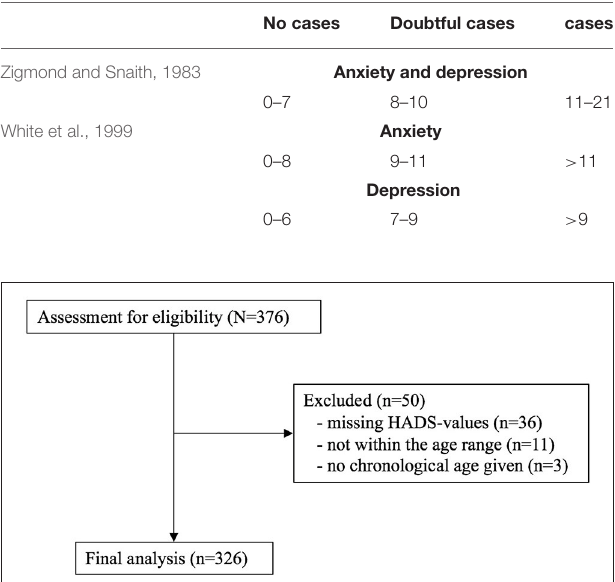
FIGURE 1 | Consort flow diagram: eligibility for inclusion in the